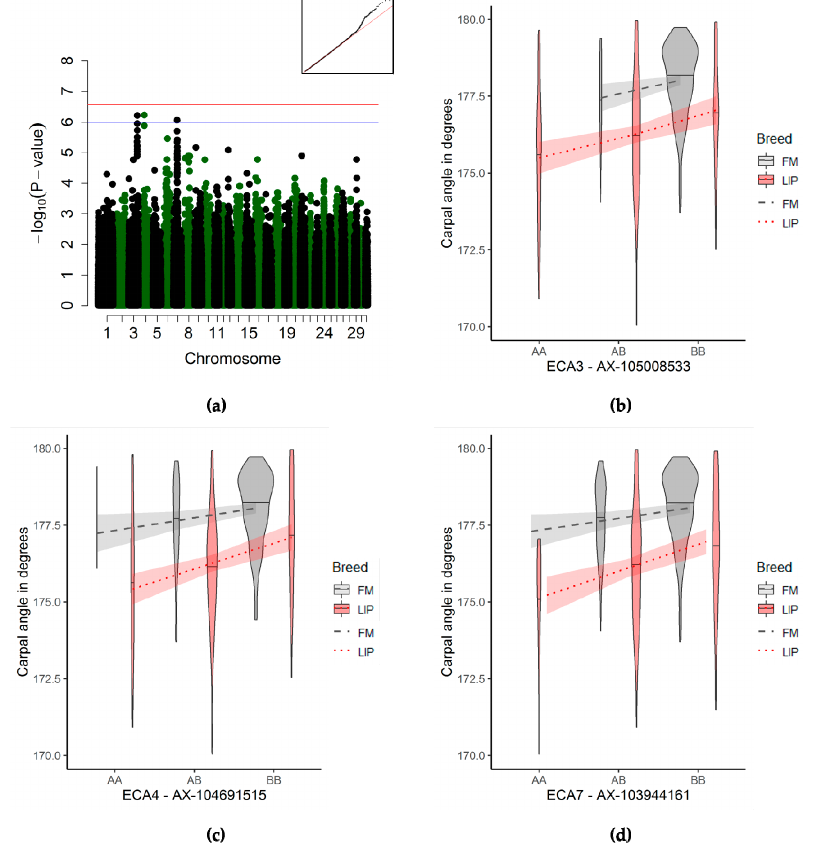
Figure 6. Genome-wide association study (GWAS) for the carpal joint angle ( n = 495). ( a ) Manhattan plot and Q–Q-plot (inset) (blue line) representing the suggestive significance threshold ( p < 10 − 6 ) and the (red line) the significance threshold ( p < 2.66 × 10 − 7 ). ( b – d ) Violin plots and trend lines (standard error in translucent) representing the genotype effect of the significant SNP on ECA3 (b), ECA4 (c), and ECA7 (d) on the carpal joint angle.